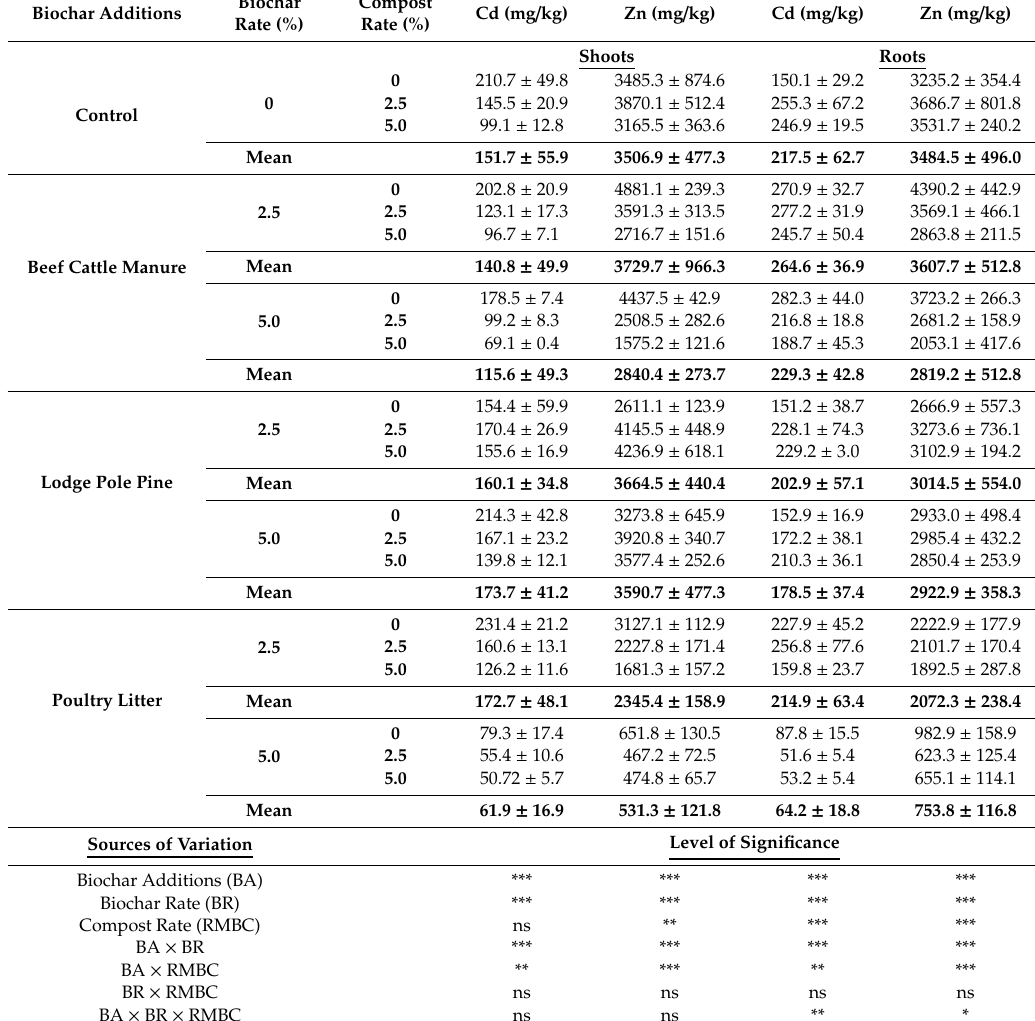
Table 4. Average concentrations of Cd and Zn in shoots and roots biomass of